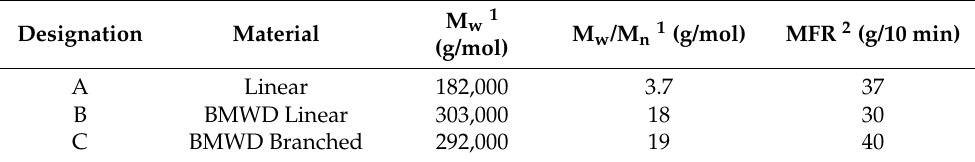
Table 1. Molecular properties of three studied resins. M w is the weight-average molecular weight, M w /M n the molecular polydispersity index, and MFR is the melt flow rate. (Data from ExxonMobil Chemical Company).